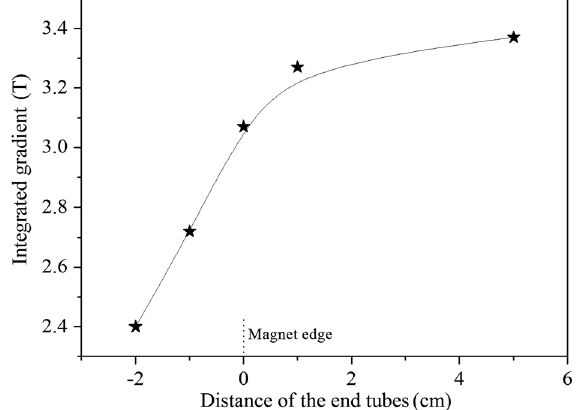
FIG. 13. Variation of integrated quadrupole gradient with the distance of the end tubes from the edge of the magnet. The joining line is a guide to the eyes.